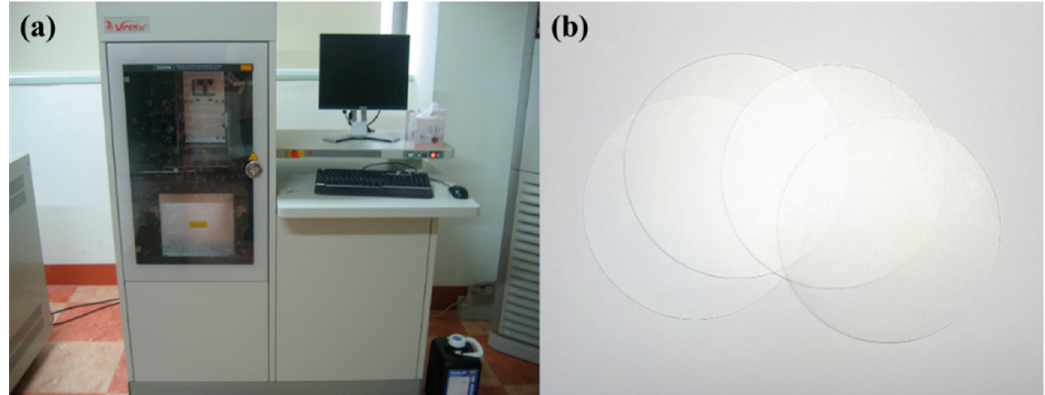
Figure 1. Three-dimensional (3D) printer and 3D printed discs: ( a ) stereolithography apparatus (SLA) 3D printer (SLA-si2) used in this study ( b ) SLA 3D printed acrylonitrile butadiene styrene (ABS)-like resin discs.